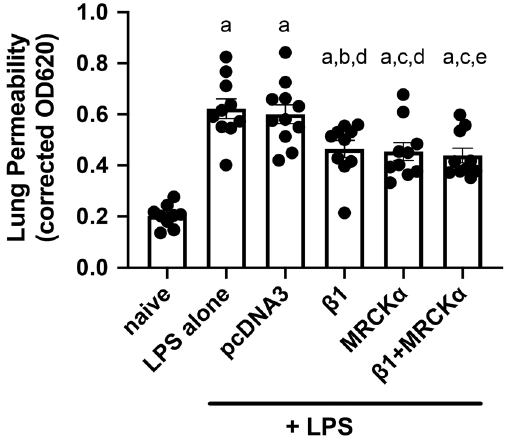
Figure 6. Electroporation mediated gene transfer of MRCKα attenuates lung leakage in lungs of mice previously injured with LPS. Lung injury was established in C57B6 mice (n = 9–11) by aspiration of LPS (5 mg/kg) and 1 day later plasmids (100 µg each) expressing either no insert (pcDNA3), the β1 subunit of the Na + , K + -ATPase (β1), MRCKα, or β1 and MRCKα were delivered in 50 µl to the lungs by aspiration followed immediately by electroporation (8 pulses of 10 ms duration each and 200 V/cm). Forty-seven hours later, Evans Blue Dye (30 mg/kg) was administered by tail vein injection and one hour later, lungs were perfused with PBS and harvested for Evans Blue Dye extraction. Lung permeability was evaluated by quantifying the absorbance of extracted Evans Blue Dye and shown as mean ± SEM. All experiments were carried out three times and a representative experiment is shown. One-way ANOVA with post-hoc Tukey’s multiple comparisons was used for statistical analysis; a, p ≤ 0.0001 compared to naïve; b, p < 0.05 compared to LPS; c, p < 0.01 compared to LPS; d, p < 0.05 compared to pcDNA3; e, p < 0.01 compared to